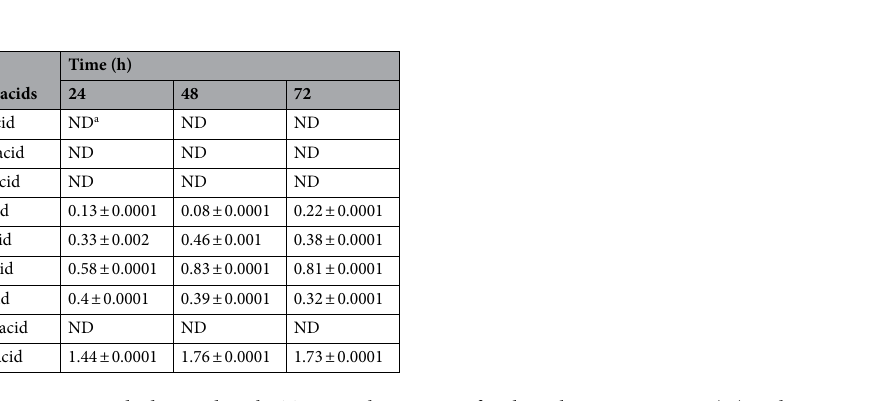
Table 2. Organic acids detected in the TBE-8 culture. *Unit for the value is percentage (%) and it represents gram of acid per 100 g of TBE-8 culture. a Symbols for ND: below detectable limit.